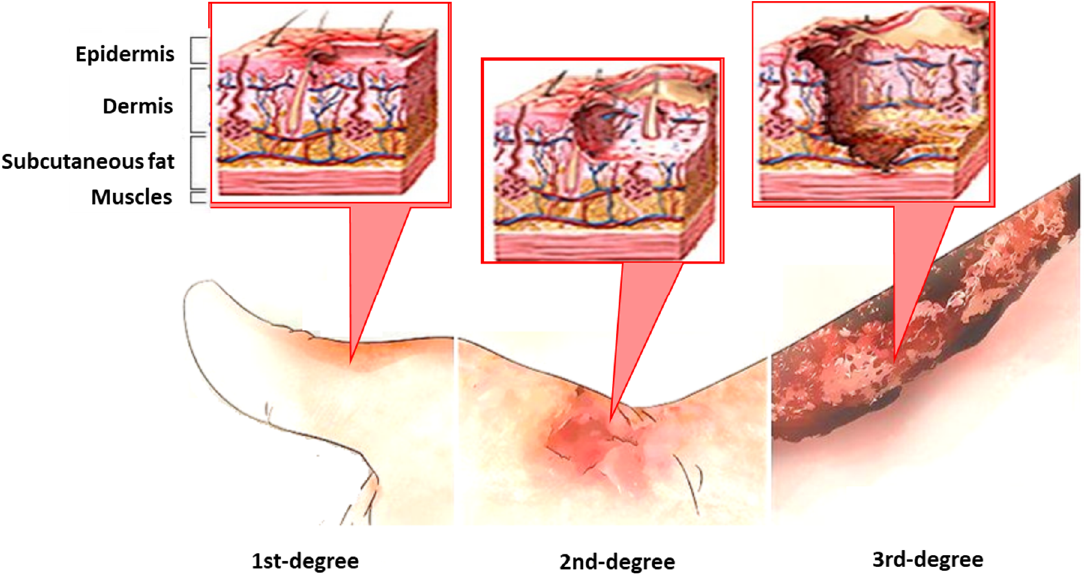
Figure 1. The classification of burns by degree is based on the depth of damage to the skin and other tissues. 1st-degree burns involve only the outer layer of skin, the epidermis; 2nd-degree burns involve the epidermis and some or all of the dermis; and 3rd-degree involve the entire dermis and destroy the hair follicles and sweat glands.